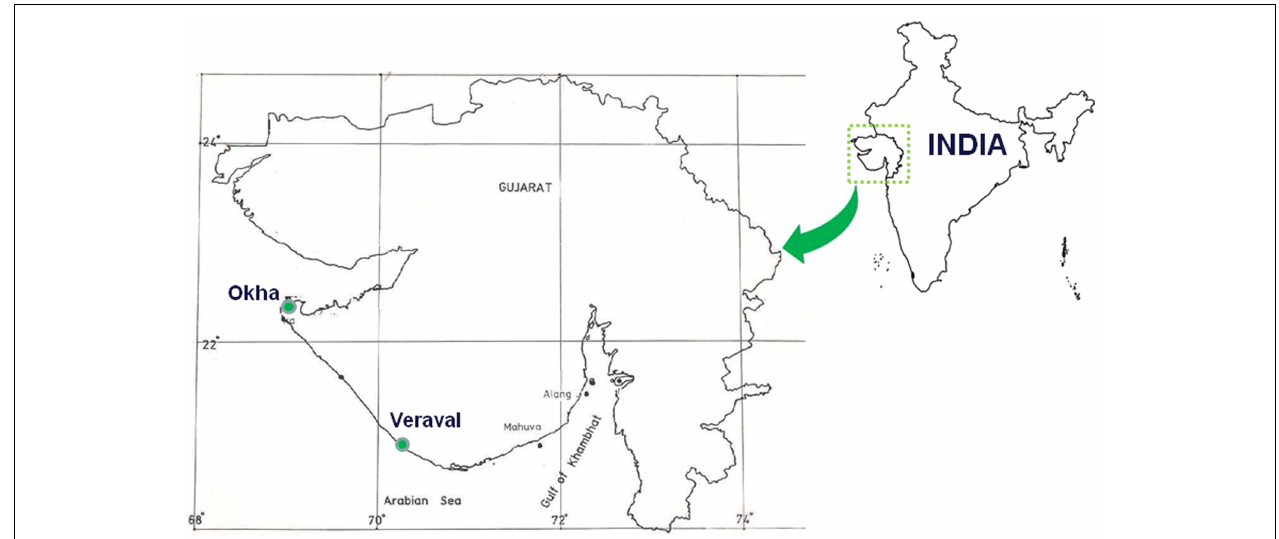
FIGURE 1 | Map of Gujarat showing macroalgal sampling locations. The land mass showing collection spots is flanked by Gulf of Kutch on northern part (Okha) and Gulf of Khambhat (Veraval) on southern part of Gujarat (Northern west coast), India.